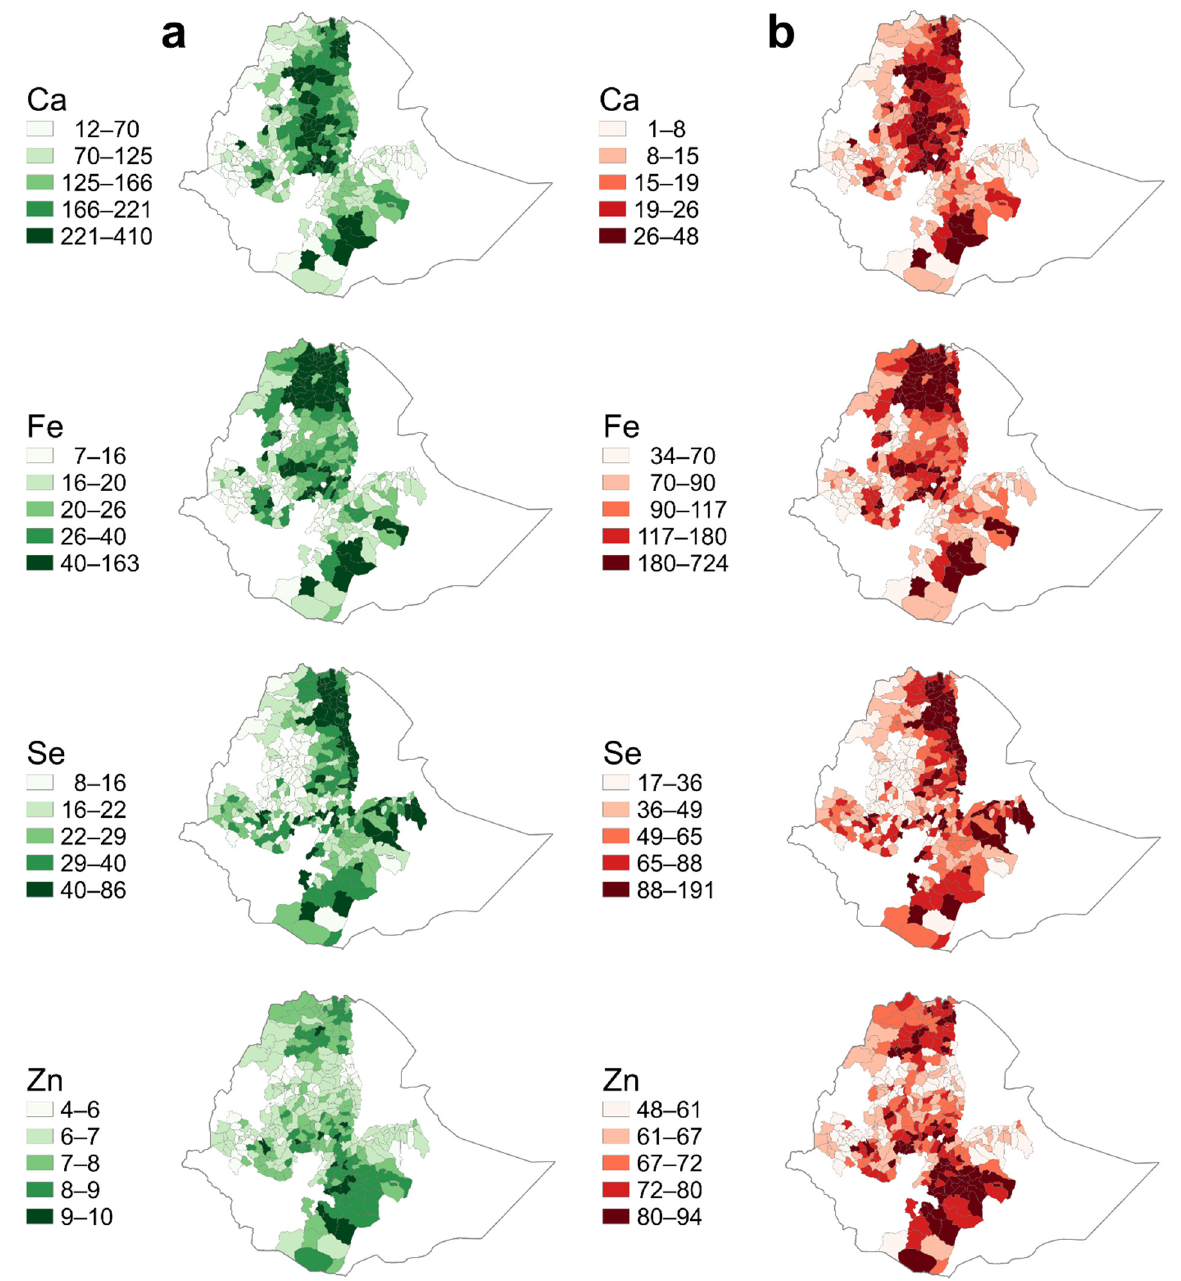
Figure 1. District-level estimates of dietary calcium (Ca), iron (Fe), selenium (Se), and zinc (Zn) supplies from staple cereals (barley, maize, sorghum, teff, and wheat), and contributions to the Estimated Average Requirement of Women of Reproductive Age in Ethiopia. ( a ) District level Ca, Fe, Se, and Zn supply from cereals assuming 300 g capita − 1 day − 1 total cereal consumption, with mixture of cereal crops in proportion to crop production quantity in a district, ( b ) District-level percentage contribution of cereals to Ca, Fe, Se, and Zn EAR for WRA. The daily Ca, Fe, and Zn supplies are expressed in mg capita − 1 day − 1 and Se is in µ g capita − 1 day − 1 . At district level, cereals can provide a median of 17% Ca, 103% Fe, 56% Se, and 69% Zn to the daily EAR. However, the contribution of cereals to the EAR varied considerably between districts (Table 3; Figure